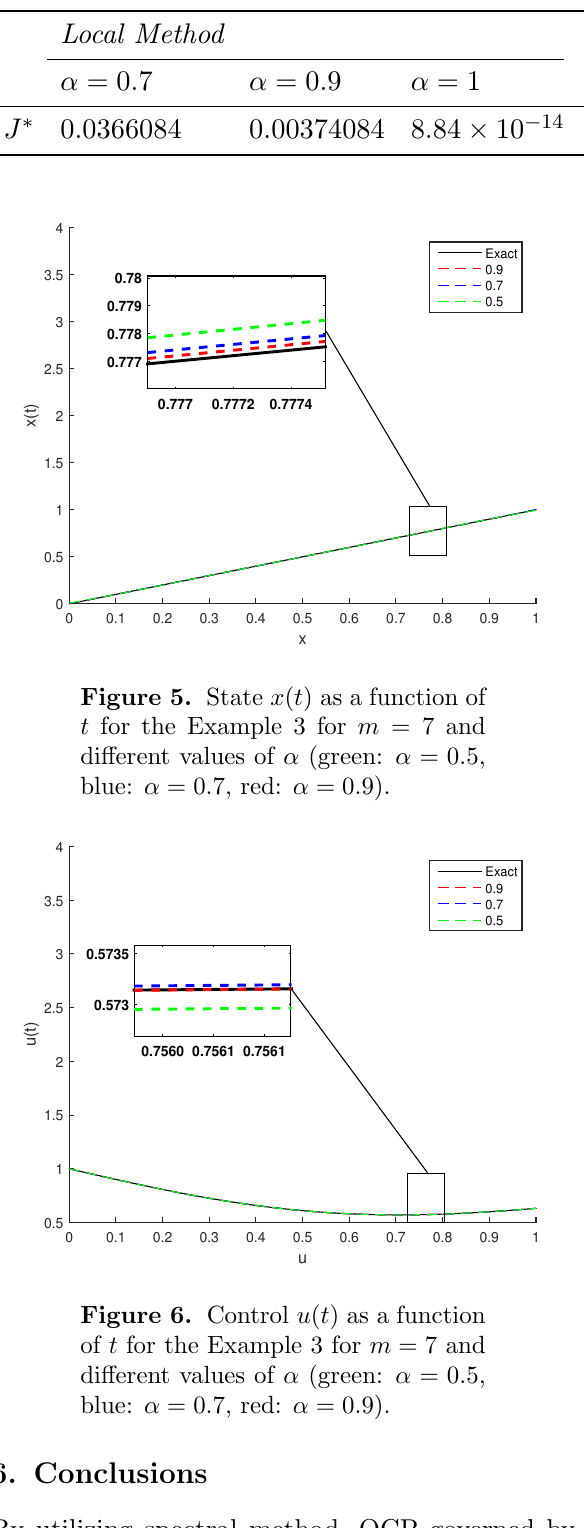
Table 3. The value of J ∗ for Example 3 ( m = 7 and different α ).